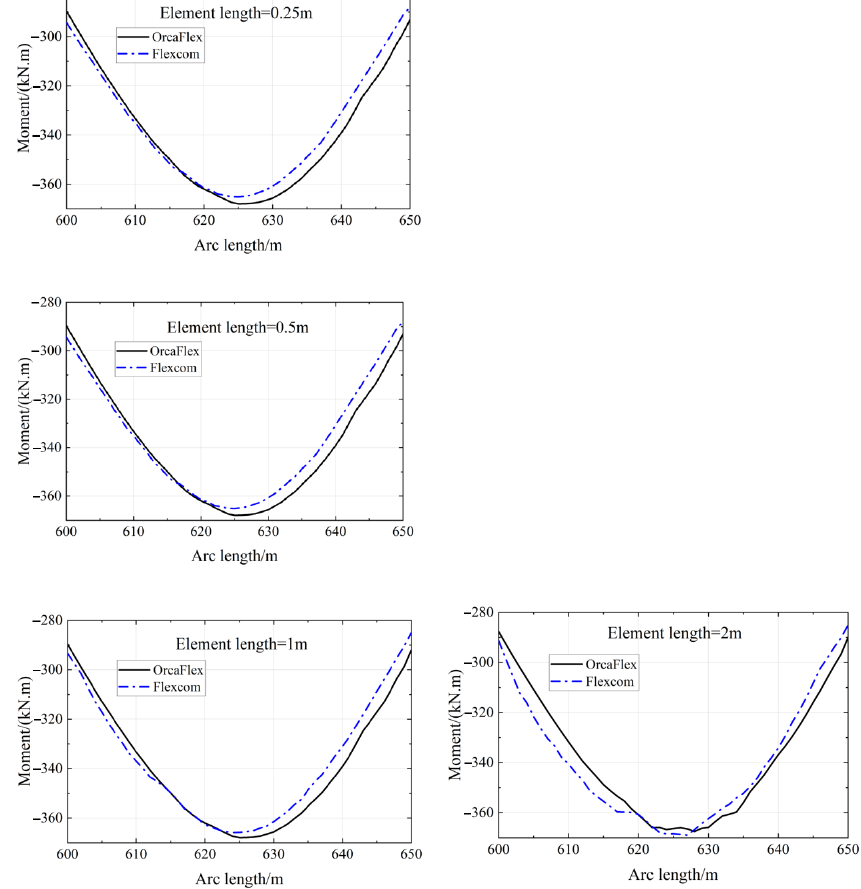
Figure 8. The bending moment distribution of different segment lengths along the length direction.